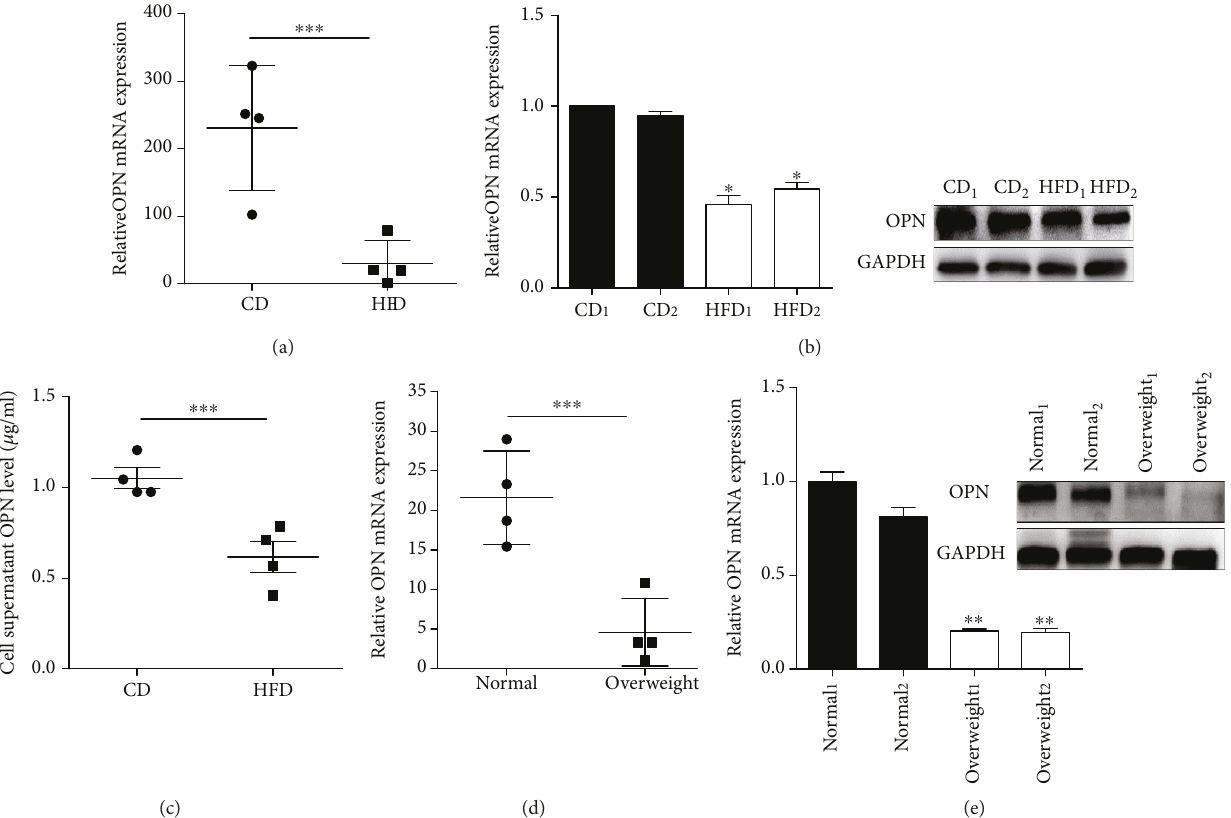
Figure 1: OPN (osteopontin) expression was detected in adipose tissue and ASCs (adipose-derived mesenchymal stem cells). (a) The expression of OPN mRNA in adipose tissue from high-fat diet- (HFD-) induced mice relative to the ones from chow diet- (CD-) induced mice. (b) Expression of OPN was detected by real-time PCR and western blot in ASCs from HFD and CD mice. (c) HFD ASCs and CD ASCs (1 × 10 6 cells) were cultured in 2ml complete medium for 48 hours. The supernatant was collected and centrifuged at 1000 × g for 4 minutes, and the OPN concentration was measured by ELISA. The OPN content of the adipose tissue (d) and ASCs in overweight and normal human subjects. (e) OPN expression was analyzed by real-time PCR and western blot. Values are means ± SEM. ∗ P < 0 05 ; ∗∗ P < 0 01 ; ∗∗∗ P < 0 001 . All experiments were repeated at least